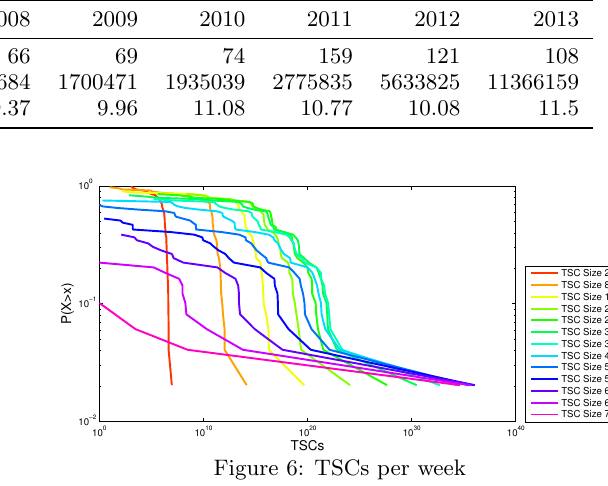
Figure 5: TSCs per day Figure 6: TSCs per